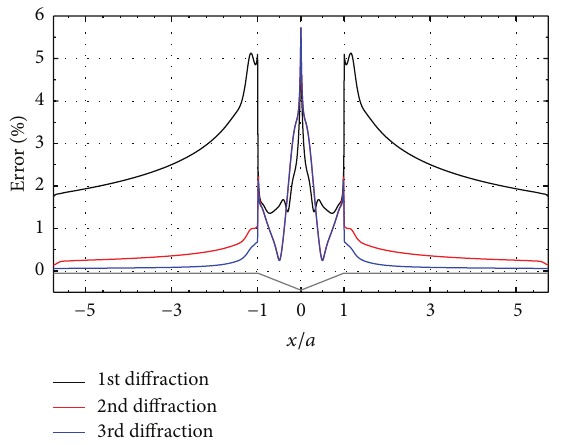
Figure 15: Total field error related to the time domain results obtainedwiththeBEMandtheSBDtechniquewith1,2,and3orders of